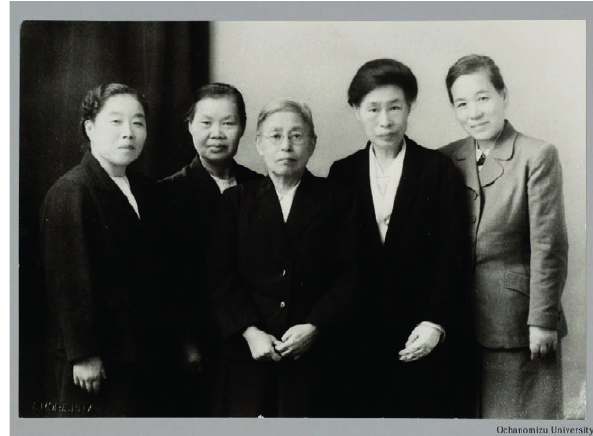
Figure 8. (Ku-6032). Faculty members of Ochanomizu University. Showa 25 about 1950. From right: 吉田武子 Yoshida Takeko, 黒田 チカ Kuroda Chika, 保井コノ Yasui Kono 辻村みちよ Tsujimura Michiyo, 和田冨起 Wada Fuki. (Courtesy of Ochanomizu University).